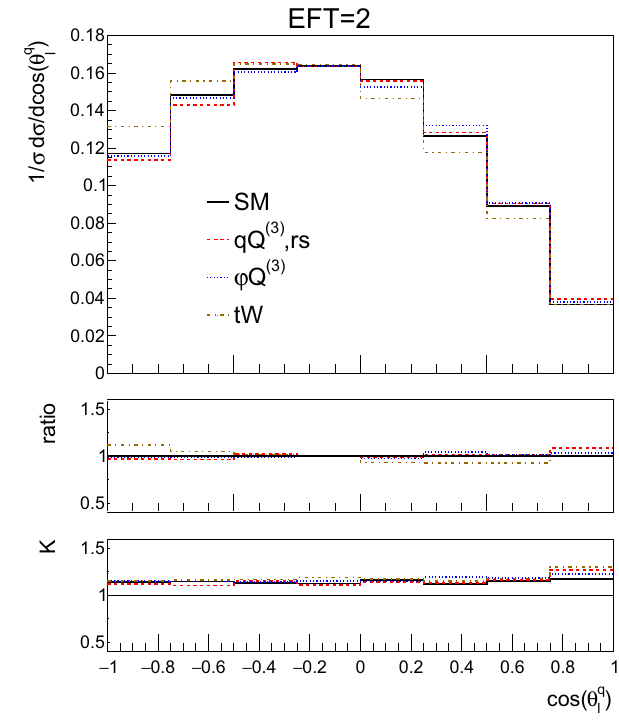
Fig. 14 The NLO distributions of the top polarisation angle (left) and W helicity (right) for the SM and the three effective operators of interest for the couplings values of Table 2. The ratio shown in the first inset is